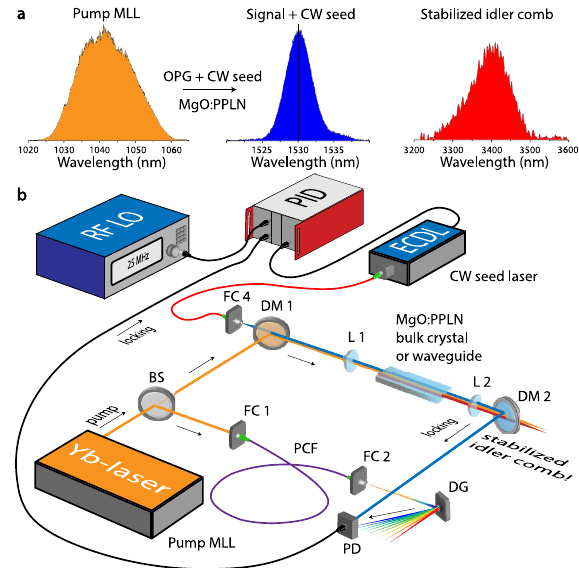
Fig. 1. (a) CW-seeded OPG concept (spectra are shown in the linear scale with arbitrary units for the case of bulk crystal). (b) Experimental setup. BS: beam splitter, FC: fiber collimator, ECDL: External Cavity Diode Laser, PCF: Photonic